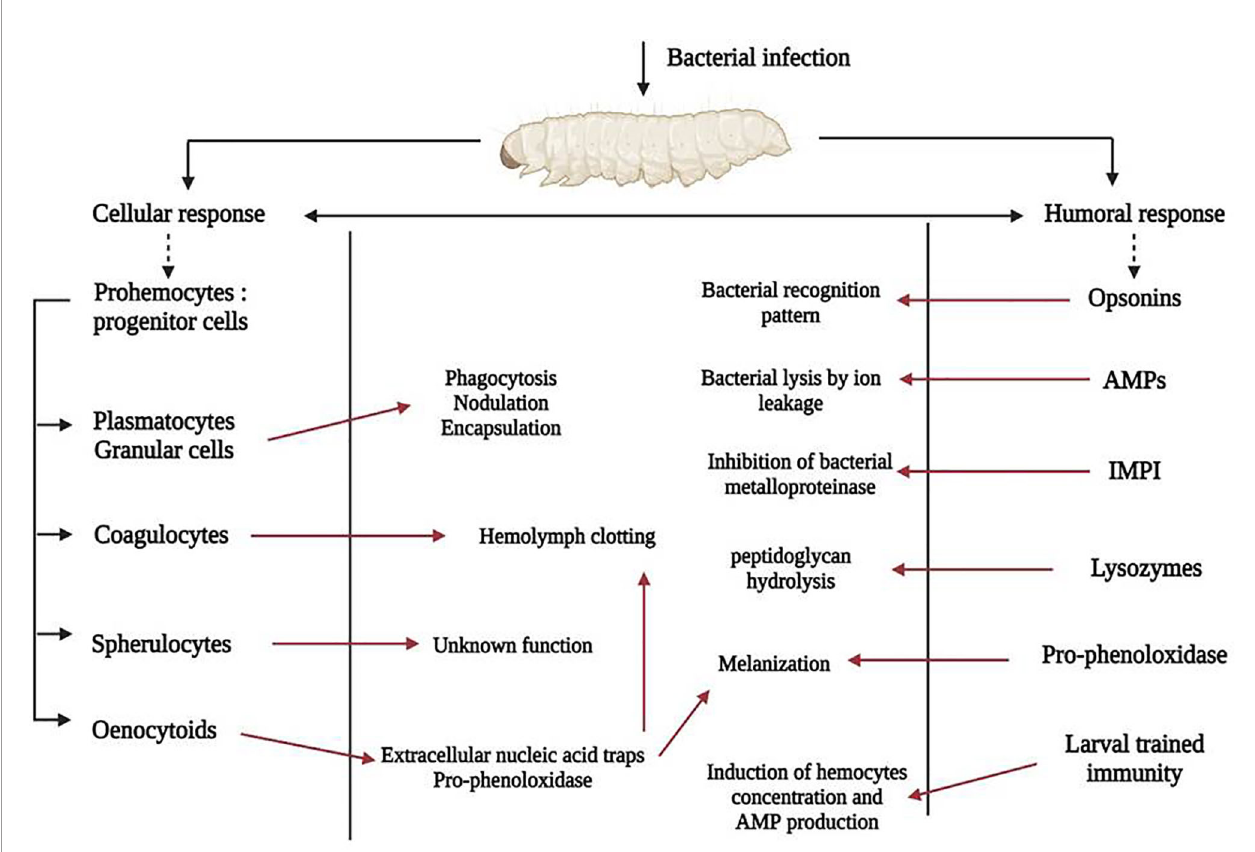
FIGURE 3 | G. mellonella immune system activation after bacterial infection. Actors of the cellular immune response are shown on the left of the picture, those of the humoral response on the right and the pathophysiological consequences in the rectangular box. Red arrows indicate